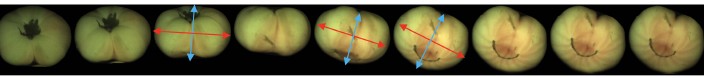
Figure 9. Views of an oblate fruit. The major principal axes are very similar in all views (2 a ≈ 2 A ). The range of the minor principal axis in each view is 2 B < 2 b i < 2 A . The minor principal axis of the spheroid is visible in the fourth view starting from the left ( b 4 ≈ B